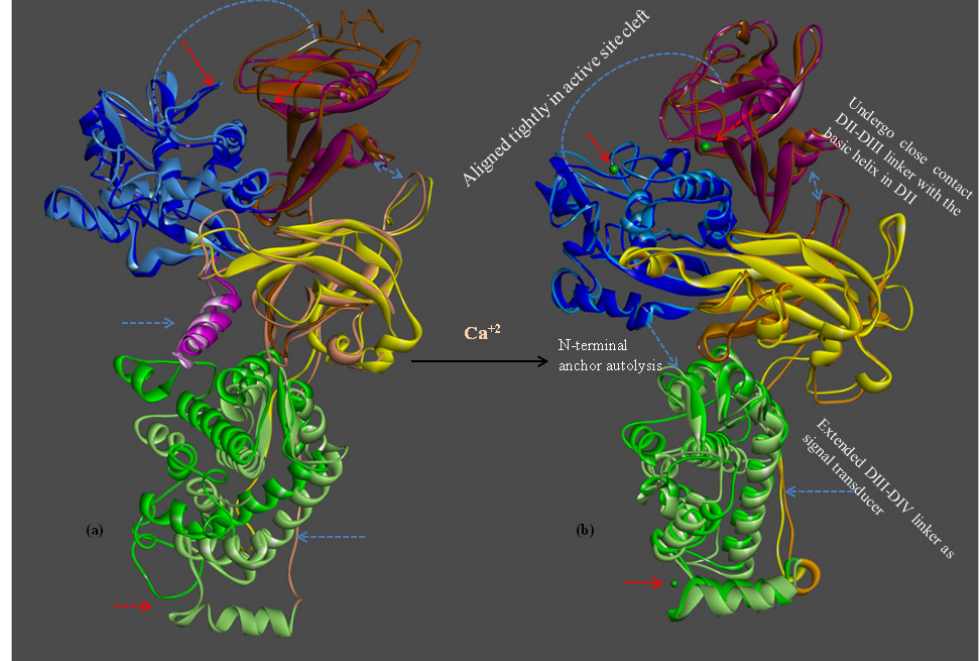
Figure 1. Bovine (CAPN1) and rat (CAPN2) structures in the absence of calcium ( a ) and bounded calcium ( b ); both large subunits with masses near 80 kDa subunits of CAPN1 and CAPN2 share 55%–65% sequence homology, and the structural similarities between them are very great. The protein structures all have the same domain color schemes: N -terminal (pink), DI (blue), DII (brown), DIII (yellow), DIV (green). The three Ca 2+ ions are shown as green spheres. Superimposition of the modeled bovine CAPN1 (dark color) and rat CAPN2 (light color) structures reveals a high degree of structural homology in all forms. The majority of structural deviations are superimposed, large catalytic subunits with and without Ca 2+ -binding. The conformational changes of both structures have been shown to resemble other CAPN